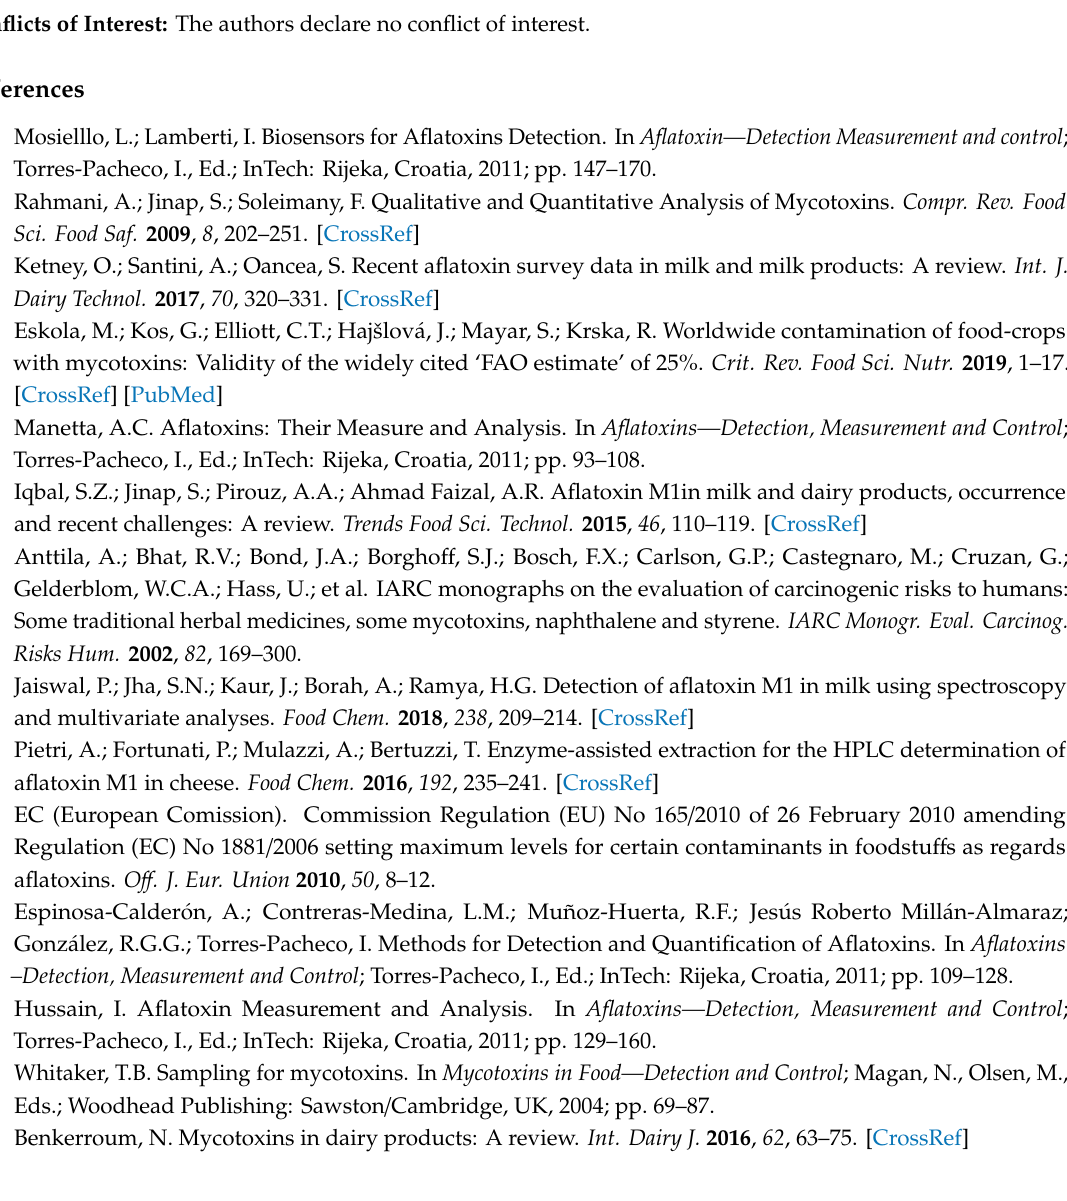
Table S1: Determination of AFM1 in milk and dairy products using di ff erent